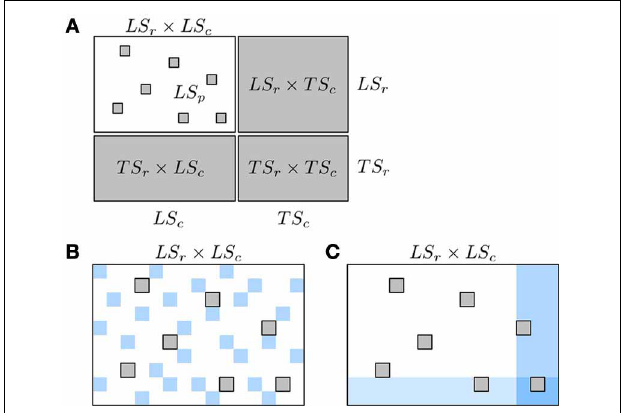
FIGURE 4 | Schematic representation of known and unknown pairs in the network adjacency matrix (A) and of the two kinds of CV, CV on pairs (B) and CV on nodes (C). In (A) : known pairs (that can be interacting or not) are in white and unknown pairs, to be predicted, are in gray. Rows and columns of the adjacency matrix have been rearranged to highlight the four families of unknown pairs described in the text: LS r × LS c , LS r × TS c , TS r × LS c , and TS r × TS c . In (B) , (C) : pairs from the learning fold are in white and pairs from the test fold are in blue. Pairs in gray represent unknown pairs that do not take part to the